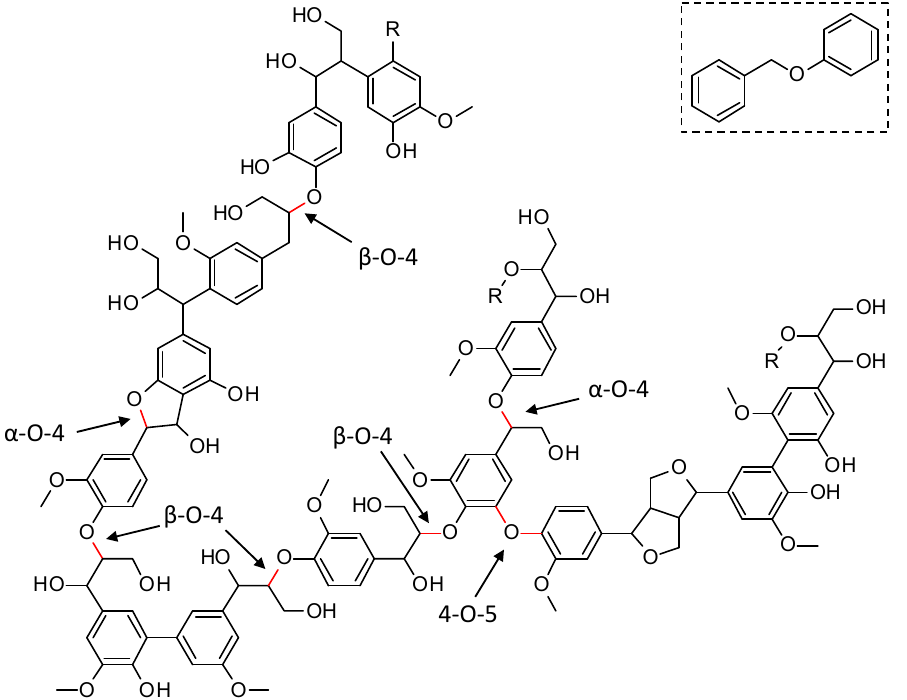
Figure 1. Representation of a native lignin structure with indication of the common C aryl -O ether linkages (in red). Benzyl phenyl ether (top right) is the model compound for the α -O-4 ether linkage in this